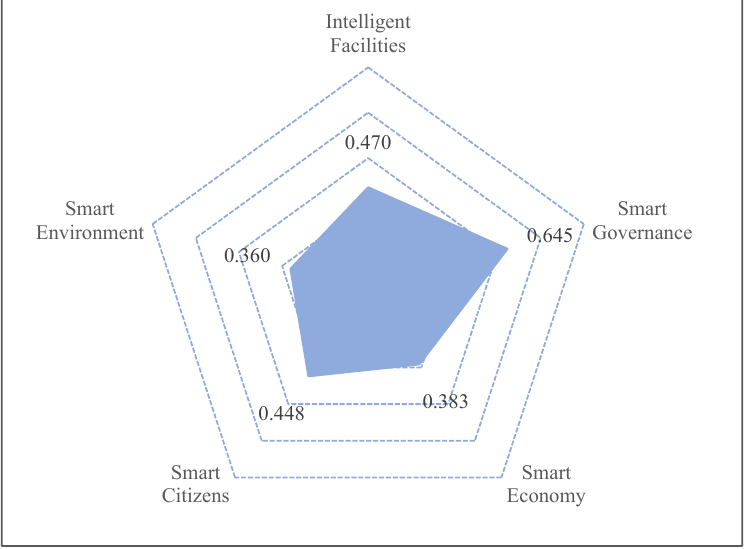
Figure 8. The smart indicators of major cities in China (revised from [15]).